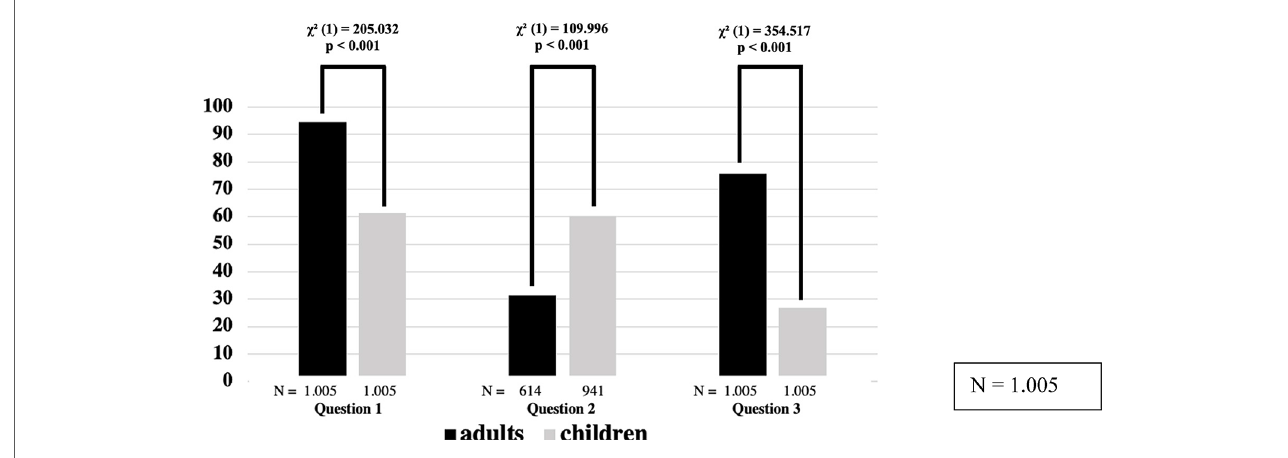
FIGURE 1 Experiences of participants. Q,question; LLC, life-limiting condition.